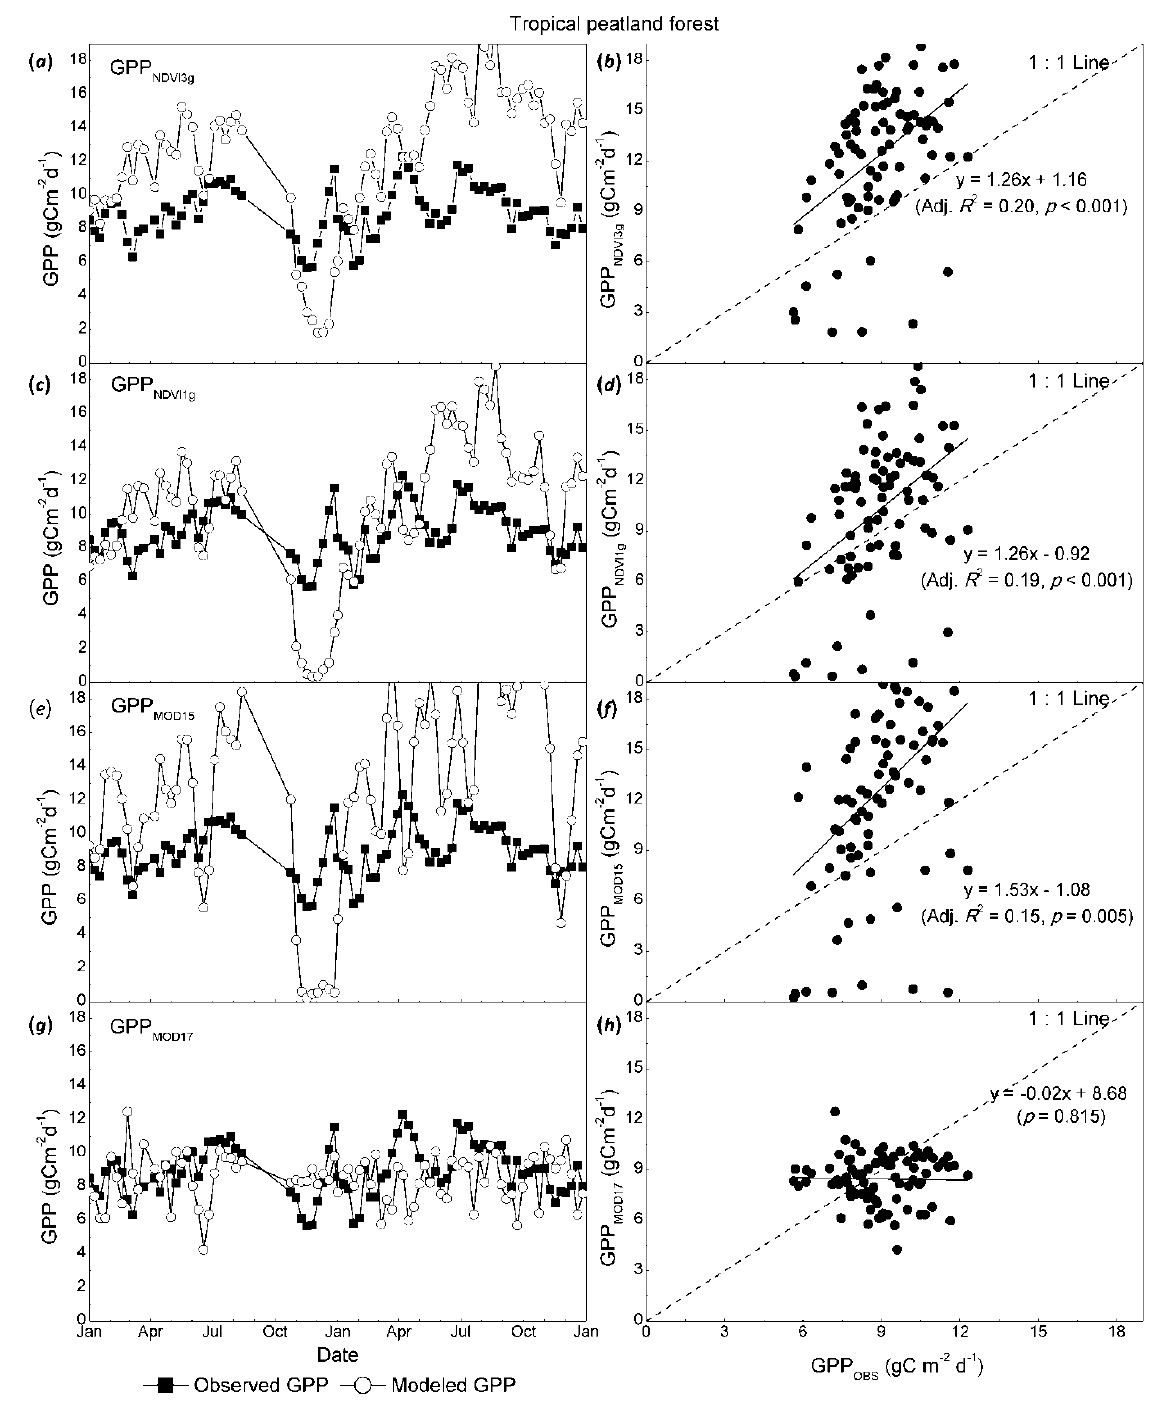
Figure 4. The eight-day mean GPP modeled using the GLOPEM-CEVSA model and the FPAR from GIMMS NDVI3g (GPP , ( a ), ( b )), GIMMS NDVI (GPP , ( c ), ( d )) NDVI3g NDVI1g and MOD15A2 (GPP , ( e ), ( f )) as well as the MODIS GPP products MOD17A2 MOD15 (GPP , ( g ), ( h )) compared with the GPP observed on the eddy covariance towers in the MOD17 PDF tropical peat land forest site. The seasonal variation ((a), (c), (e), (g)) and the scatter plots ((b), (d), (f), (h)) of the two kinds of GPPs are compared for all the four GPP products (GPP , GPP , GPP , and GPP ). Sample number is NDVI3g NDVI1g MOD15 MOD17